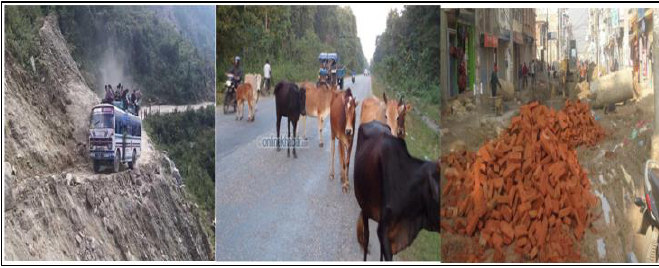
Figure 3: Causes of accidents.